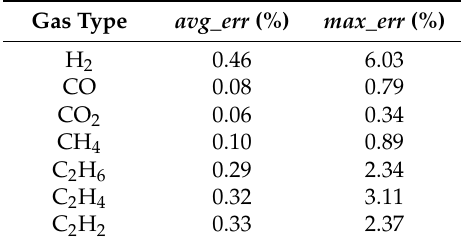
Table 3. NAR–DWT prediction error for oil-dissolved gas